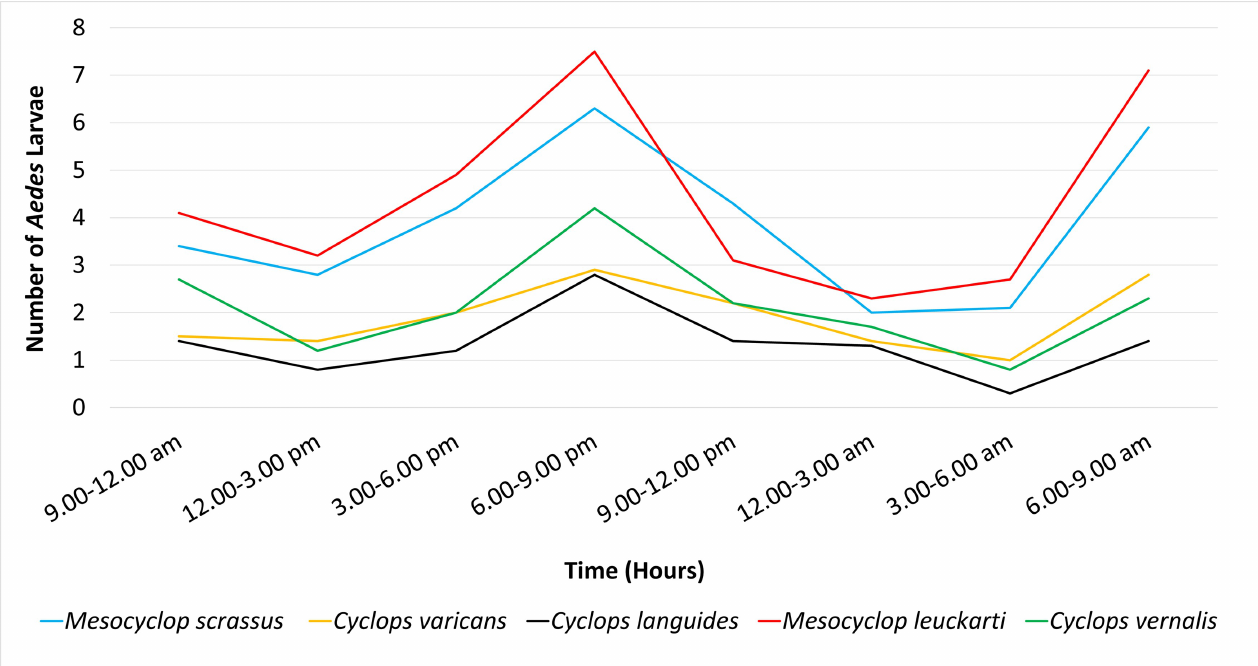
Fig 2. Temporal variation of the predation rates of studied copepods on Ae . aegypti larvae.